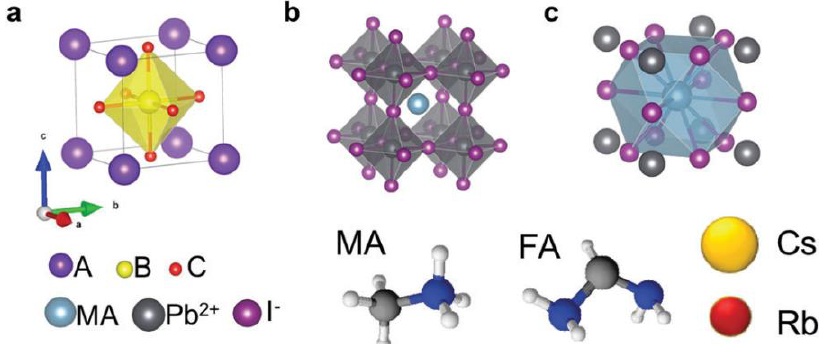
Figure 1. Structural features for metal halide perovskites. ( a ) Unit cell of general cubic perovskite; ( b ) MAPbI 3 with octahedral coordination around lead ions; ( c ) MAPbI 3 with cuboctahedra coordination around organic ions. Reprinted with permission [27]. Copyright 2017, Royal Society of